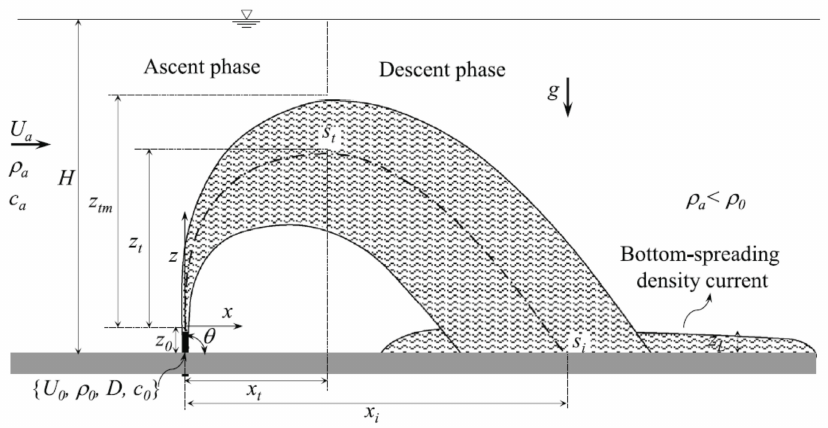
Figure 1. Definition sketch of a dense jet in a water body [37] ( g is the acceleration due to gravity, c 0 is the initial jet fluid conductivity, and c a is the ambient fluid conductivity ( c a < c 0